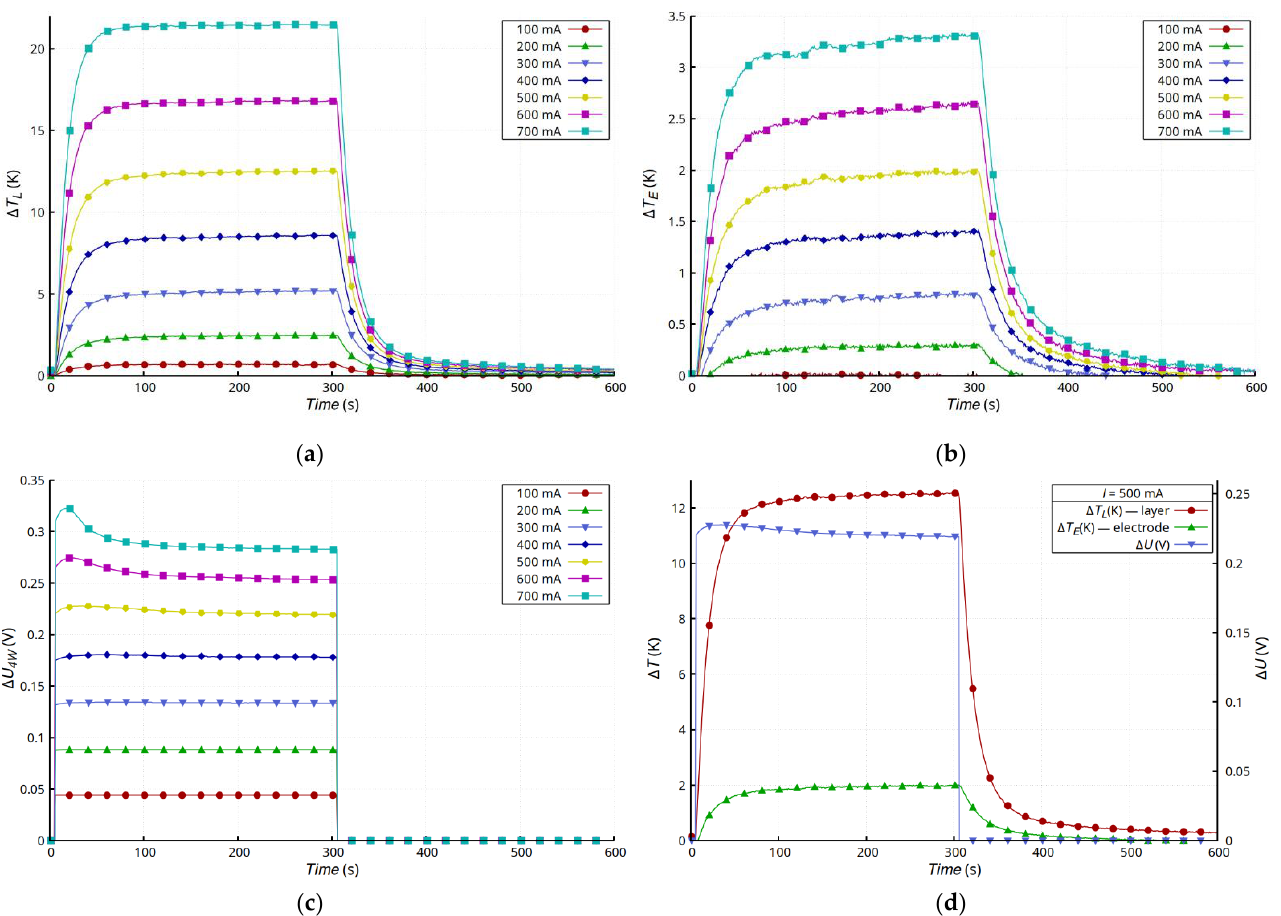
Figure 10. Results for sample M + T: time dependence of changes in temperature of Ag layer Δ T L ( a ); changes in temperature of electrode Δ T E ( b ); drop voltage on sample Δ U 4W ( c ); comparison of results for I = 500 mA ( d ).